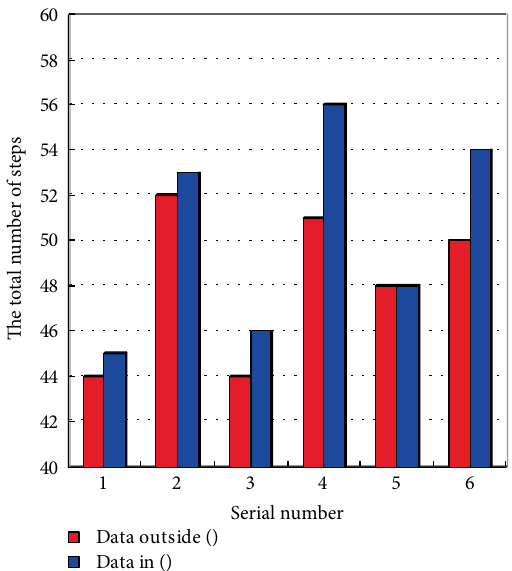
Figure 6: A comparison chart of 𝑠 sum when there is an obstacle.